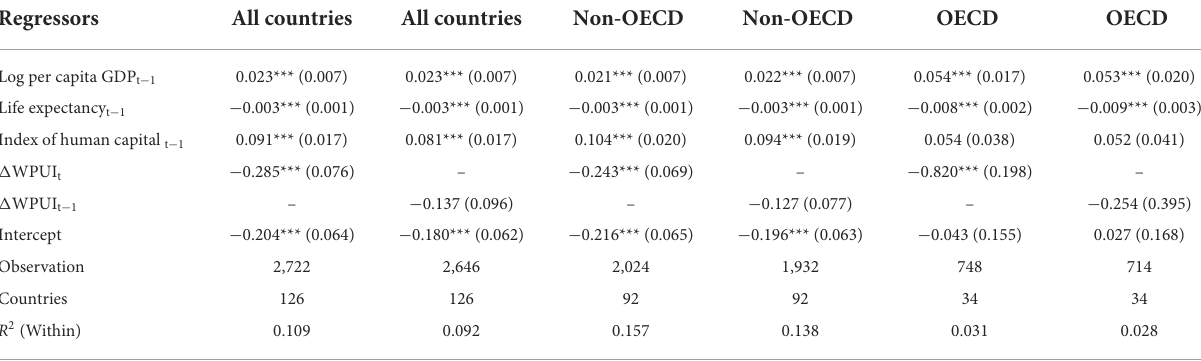
TABLE 3 Fixed-effects estimations for Model II